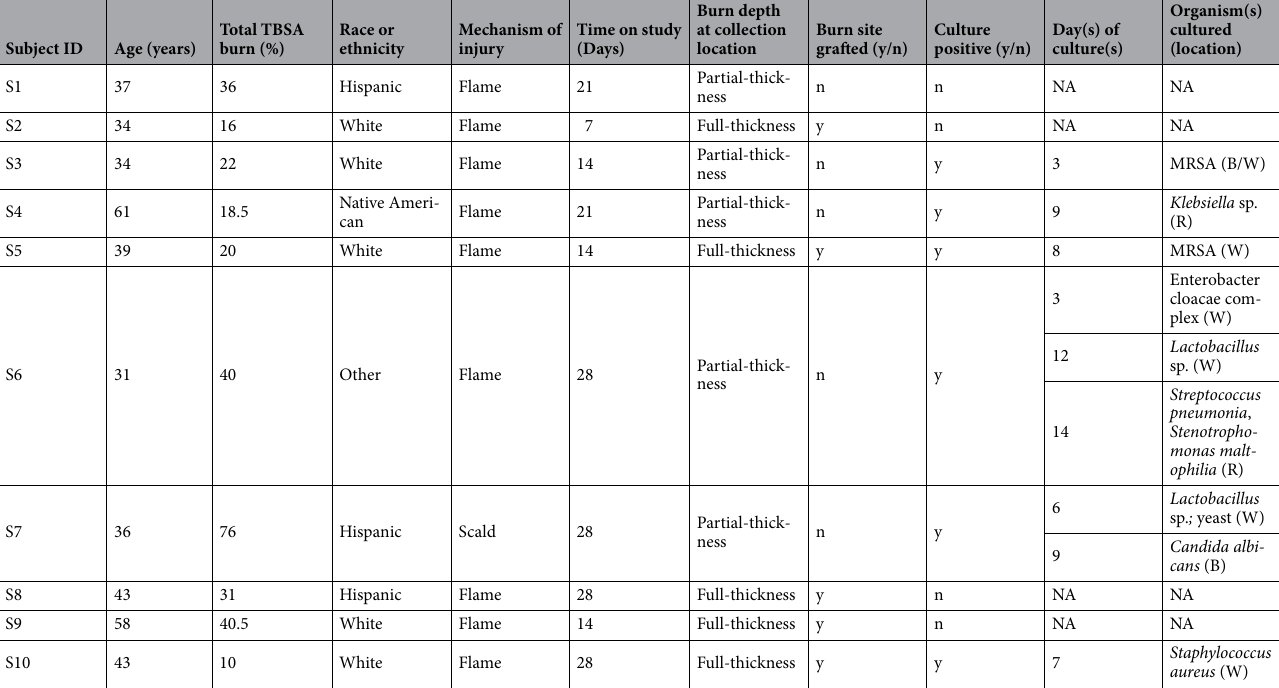
Table 1. Burn patient demographics. B blood, R respiratory, W wound.